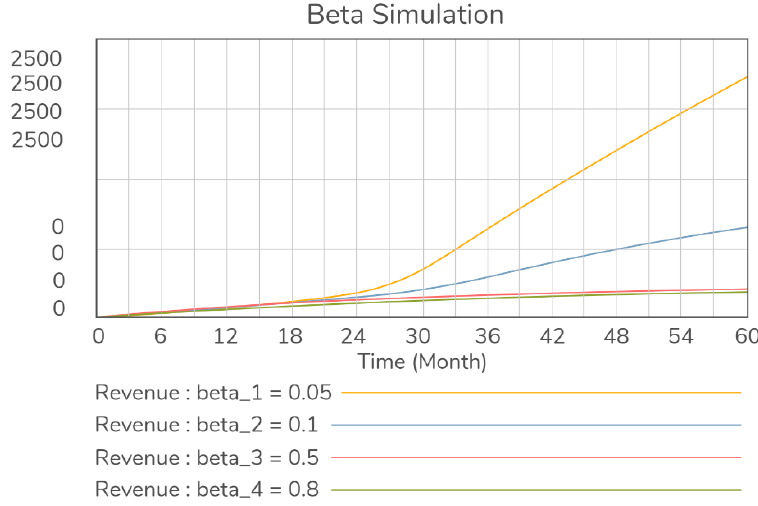
Figure 10. The OI simulation with four different betas (Failure